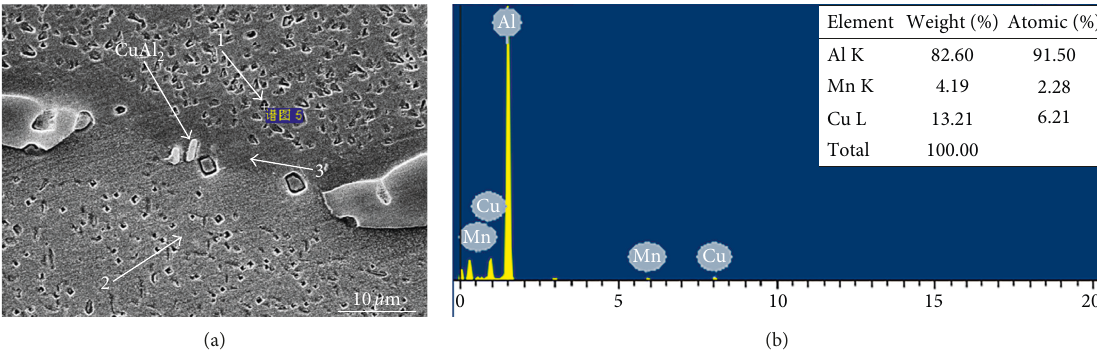
Figure 2: SEM image showing the precipitated particles (a) and its EDS results marked by Arrow 1 (b) in the A